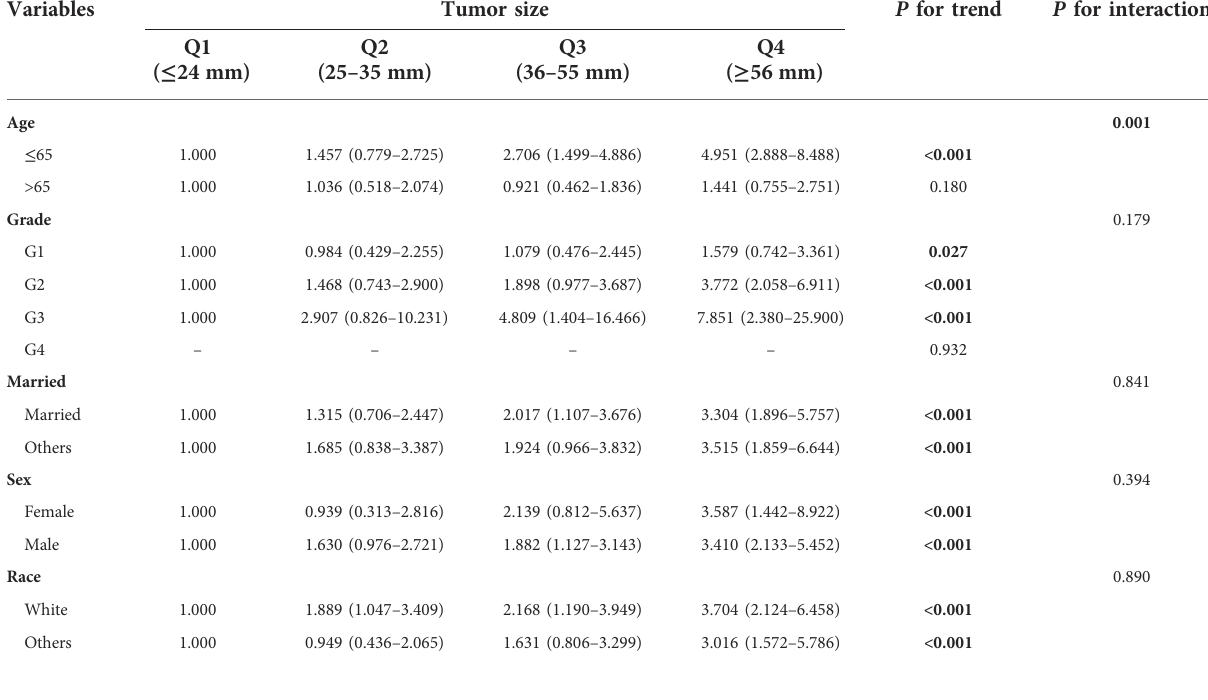
TABLE 3 Test for trend and interaction between tumor size and other variables in SEER database